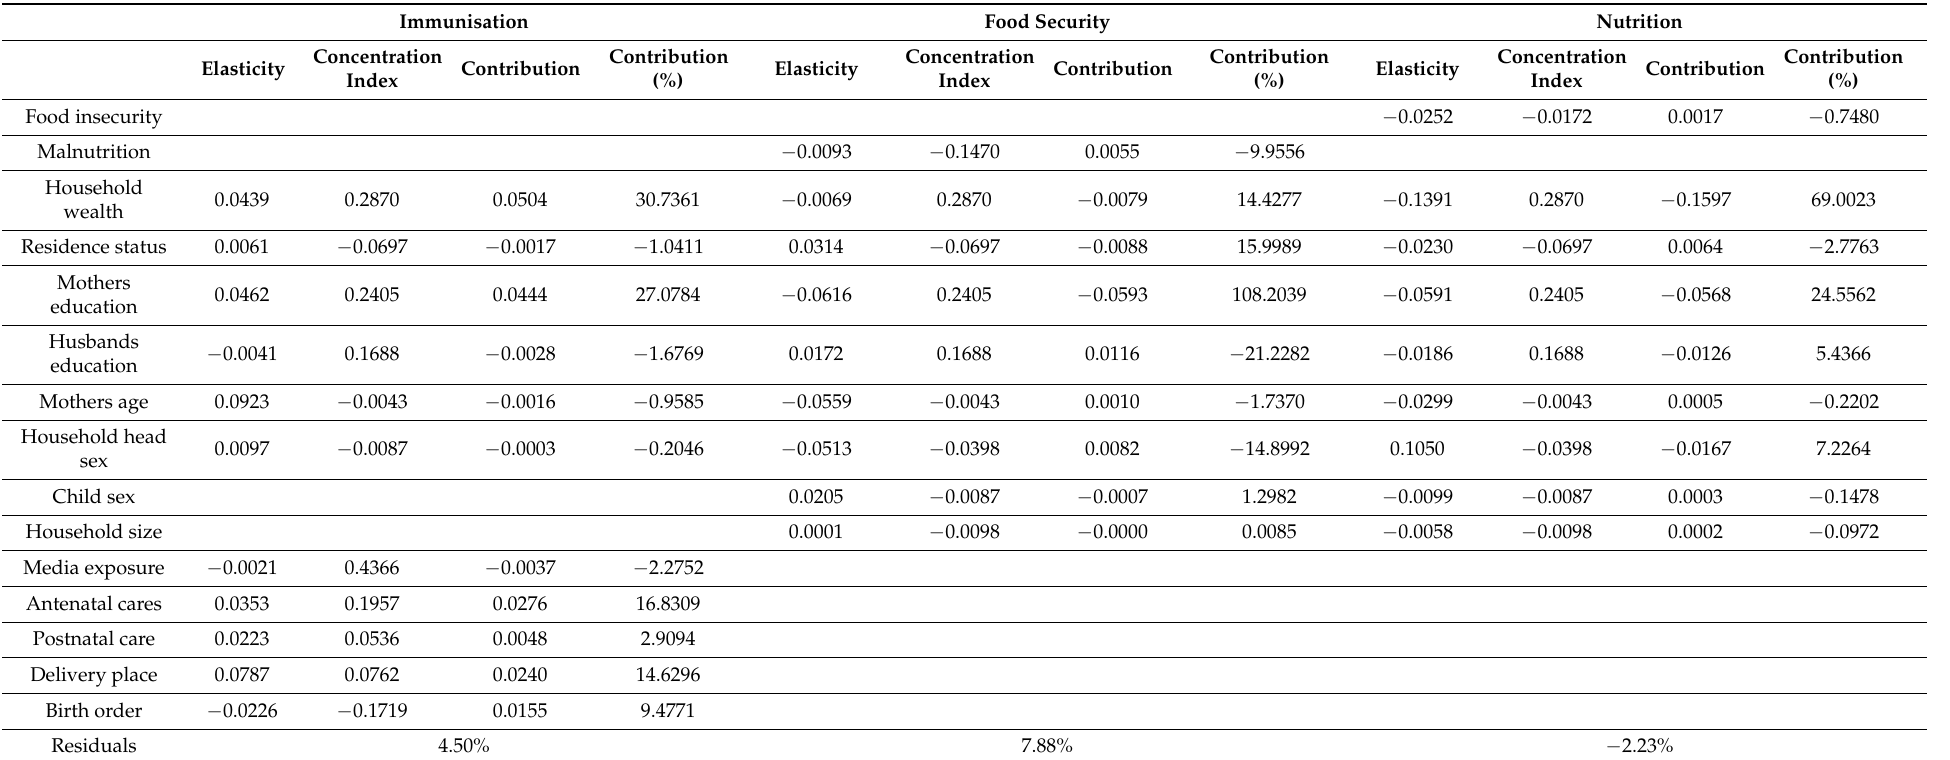
Table 5. Decomposition child health indicators across child health determinants in